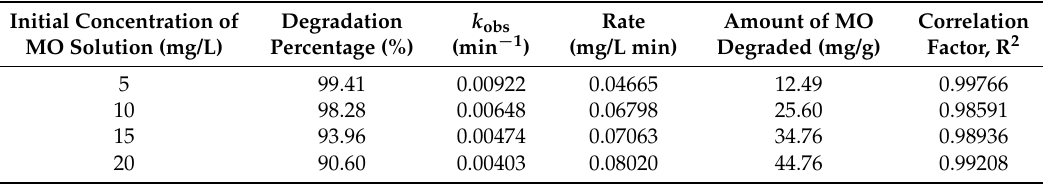
Table 3. Kinetic data and the amount of MO degraded at different initial concentration by the PZ-17 film